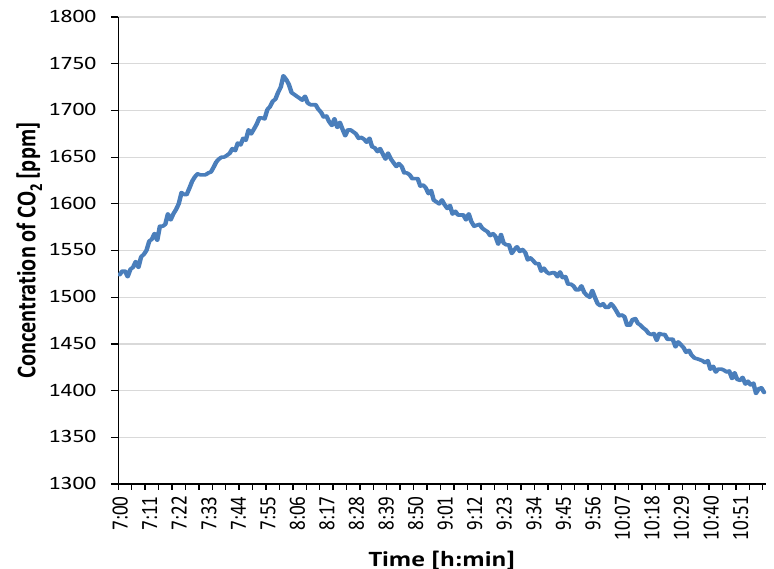
Figure 7. Recording of concentration of CO 2 for selected day 3 February 2019 No 15.